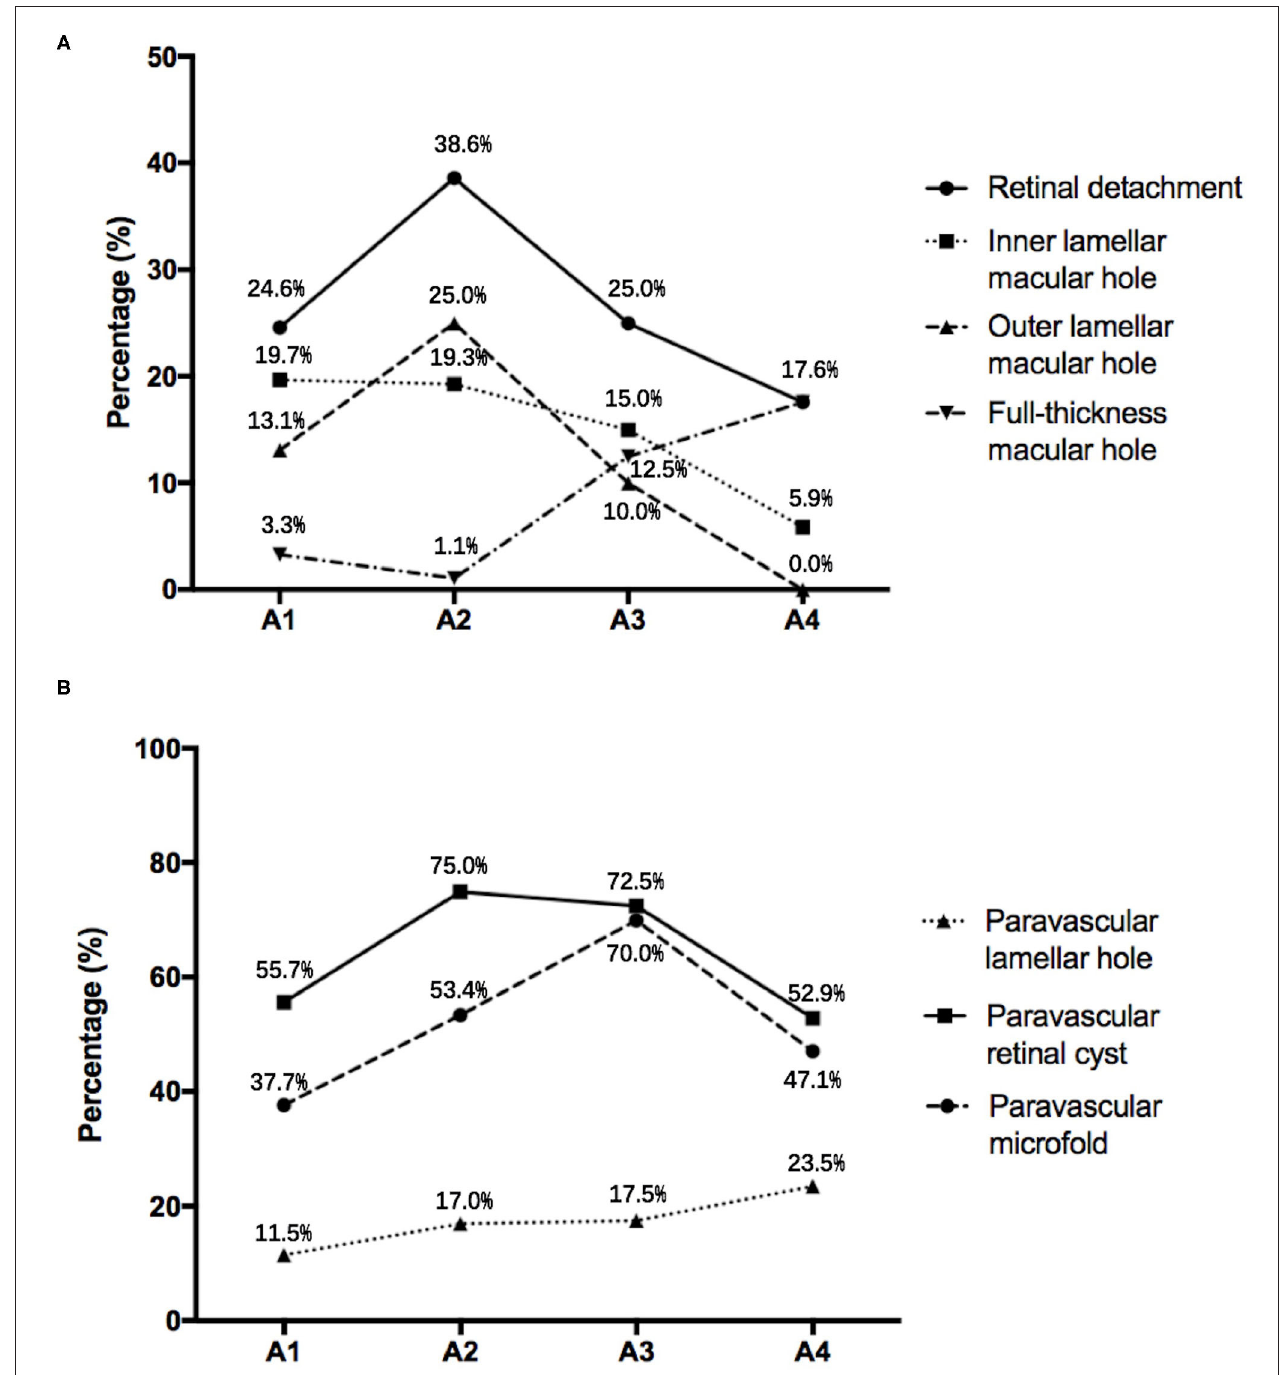
FIGURE 3 | (A) The incidence of complications of myopic retinoschisis in different myopic atrophy maculopathy (MAM) grades. (B) The incidence of paravascular abnormalities in different stages of MAM. A1, tessellated fundus; A2, diffuse chorioretinal atrophy; A3, patchy chorioretinal atrophy; A4, macular atrophy.